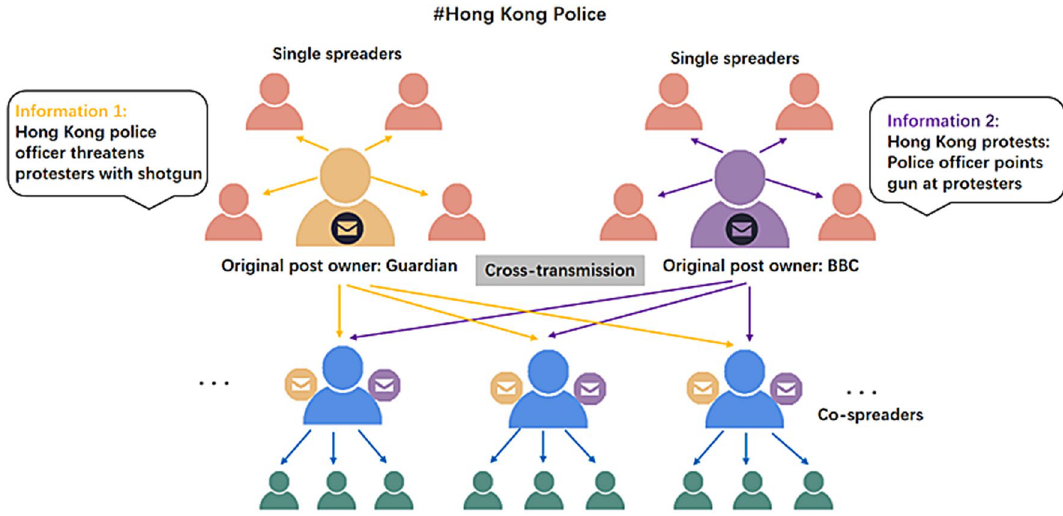
Figure 1. Cross-transmission of one public hot event about Hong Kong